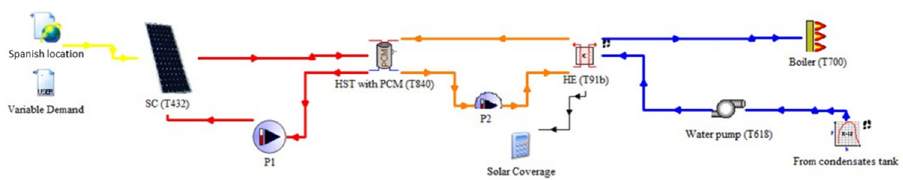
Figure 6. Solar integration scheme for the Spanish winery demo site based on the use of Viessmann solar thermal collectors for hot water generation and a heat storage tank with PCM.